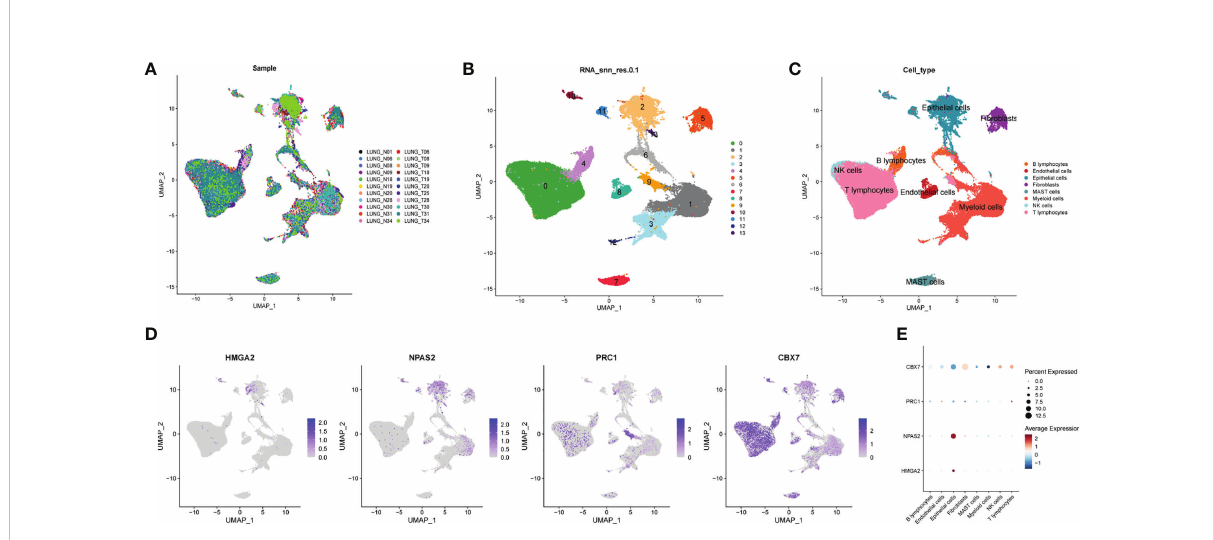
FIGURE 6 Single cell sequencing analysis. (A) The integration effect of 22 samples is favorable. (B) All cells in 22 samples were divided into 13 subgroups. (C) The cells were divided into 8 types of cell subgroups, namely B lymphocytes, endothelial cells, epithelial cells, fi broblasts, mast cells, myeloid cells, NK cells and T lymphocytes. (D) Cell location of four model CRs. (E) Correlation analysis of four model CRs and 8 types of cell